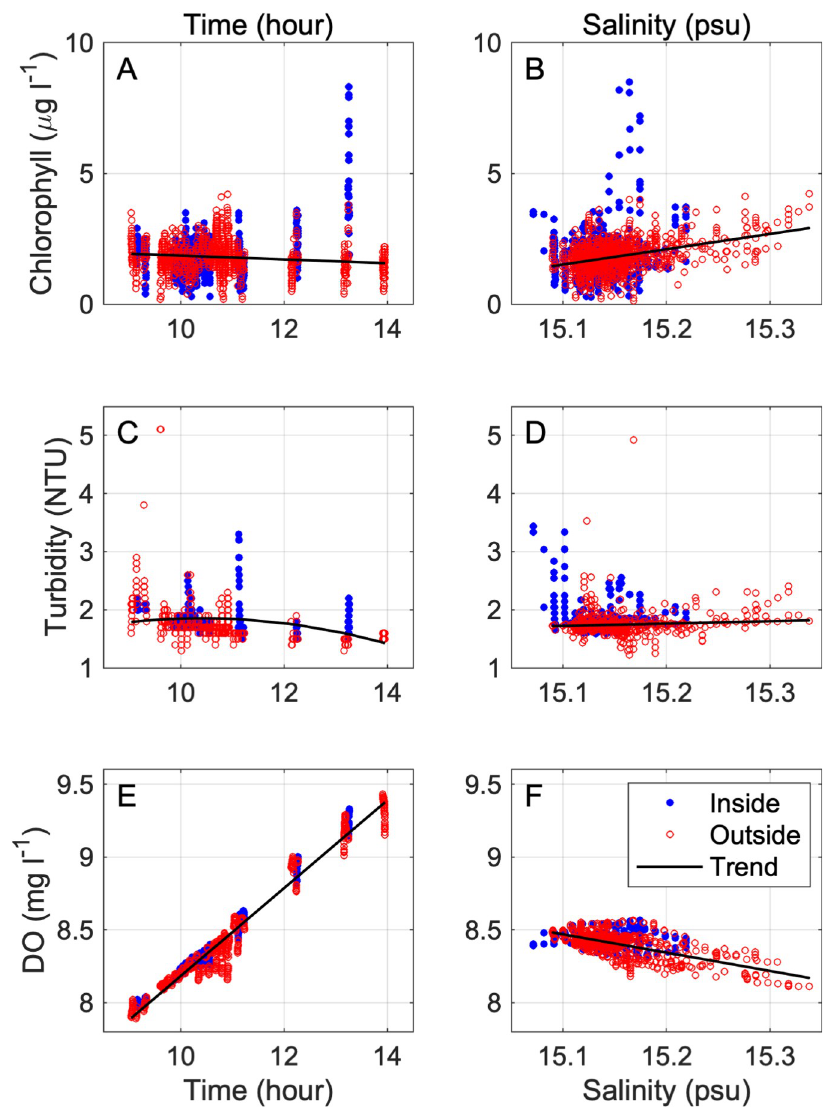
Fig 3. Water quality detrending process for transect data. To account for trends associated with time of day, such as warming temperatures throughout the day, water quality data were detrended with respect to (A, B, C) time and (D, E, F) salinity. Red circles indicate points sampled inside and blue circles indicate points sampled outside the farm footprints. Current speed was detrended with respect to time, but not salinity.